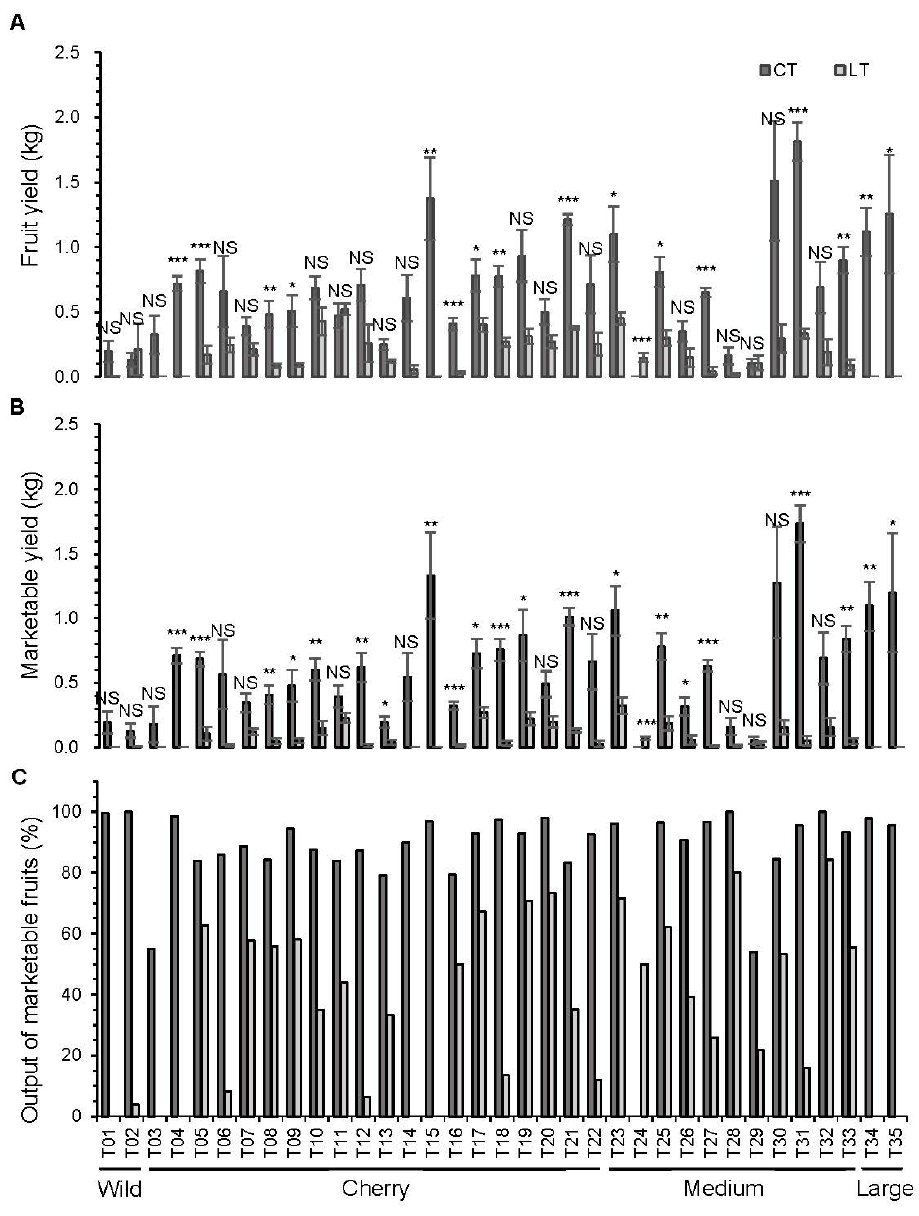
Figure 4. The analysis of reproductive traits on ( A ) fruit yield, ( B ) marketable yield, and ( C ) output of marketable fruit among 35 tomato accessions with different fruit types in CT and LT greenhouses. Significant differences were evaluated with Student’s t -test ( p ≤ 0.05, p ≤ 0.01, and p ≤ 0.001) and are denoted by *, **, and ***, respectively. NS indicates not significant and bars indicate ± standard deviation ( n =